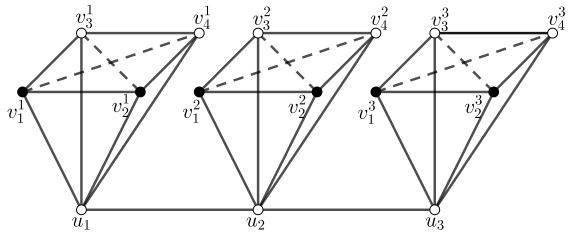
Figure 1. P 3 (cid:12) K 4 with its nr -set W = { v 1